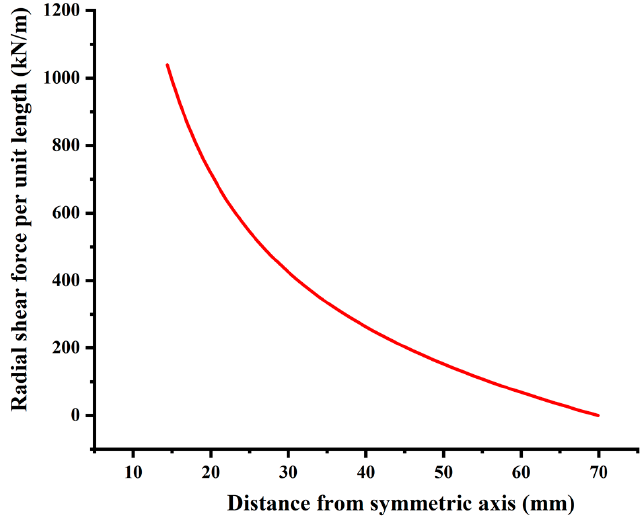
Figure 11. The tray thickness does not affect the tray radial shear force. The maximum shear force is 1038.93 kN/m at the inner wall and gradually decreases to 0 along the radial direction.